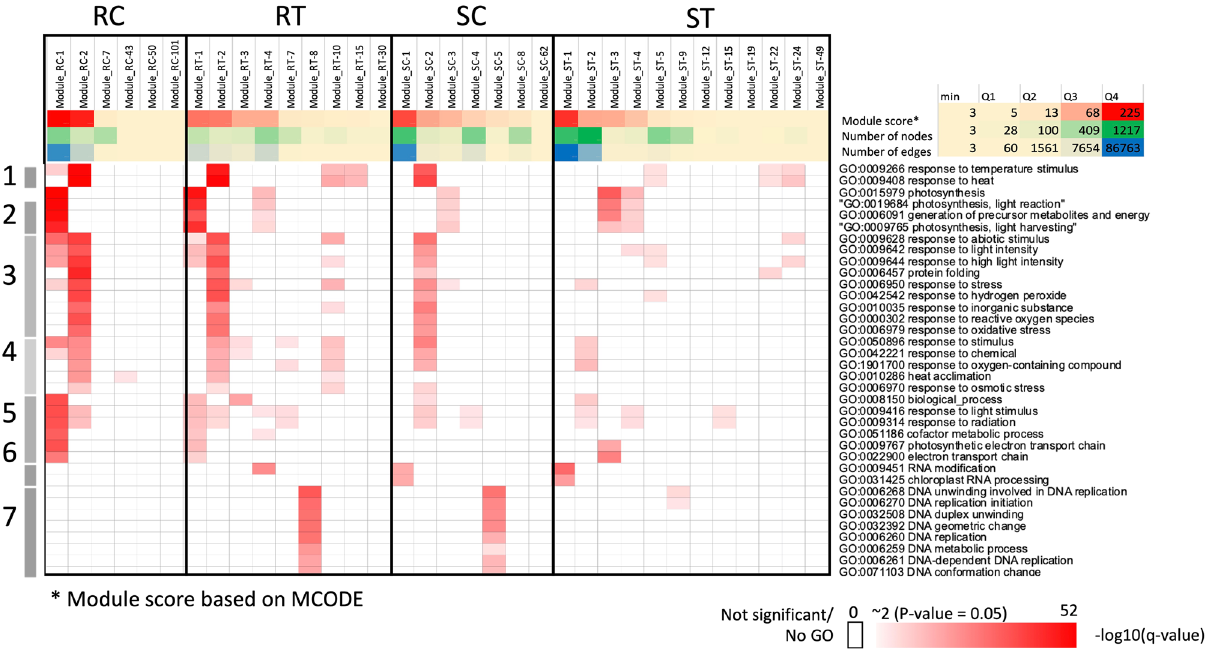
Figure 3. Functional analysis of modular gene networks. Heatmap demonstrating highly enriched biological process functions of each module (–log 10 Q-value more than 10; see Additional Information 5A for full analysis results). The columns represent modules, rows represent functions determined for the seven clades: clade1 for heat response, clade2 for photosynthesis, clade3 for stress response, clade4 for the chemical response, clade5 for the light response, clade6 for RNA processing and clade7 for DNA processing, and colors represent the significance